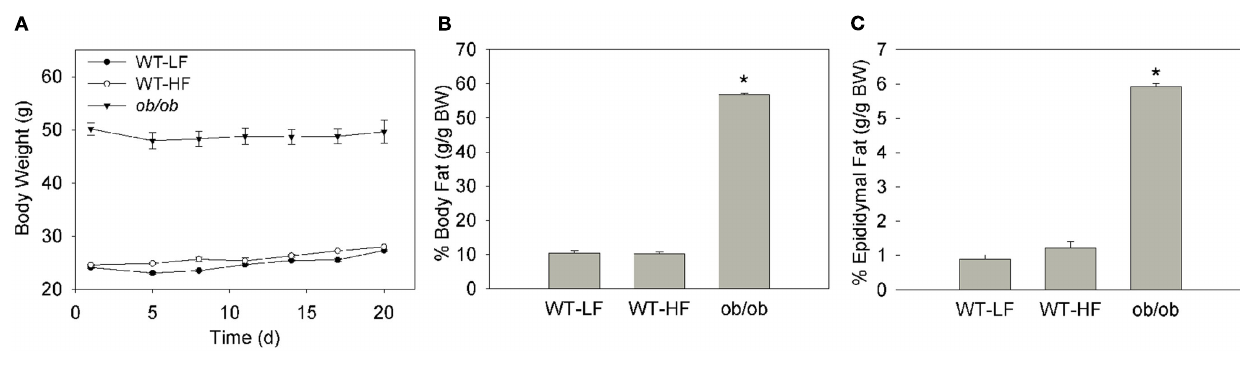
FIGURE 1 |Weight and body fat of mouse models. (A) Average body weight of mice over the 3-week feeding study. Error bars may not be visible within data point. (B) Percent body fat as determined by EchoMRI. (C)